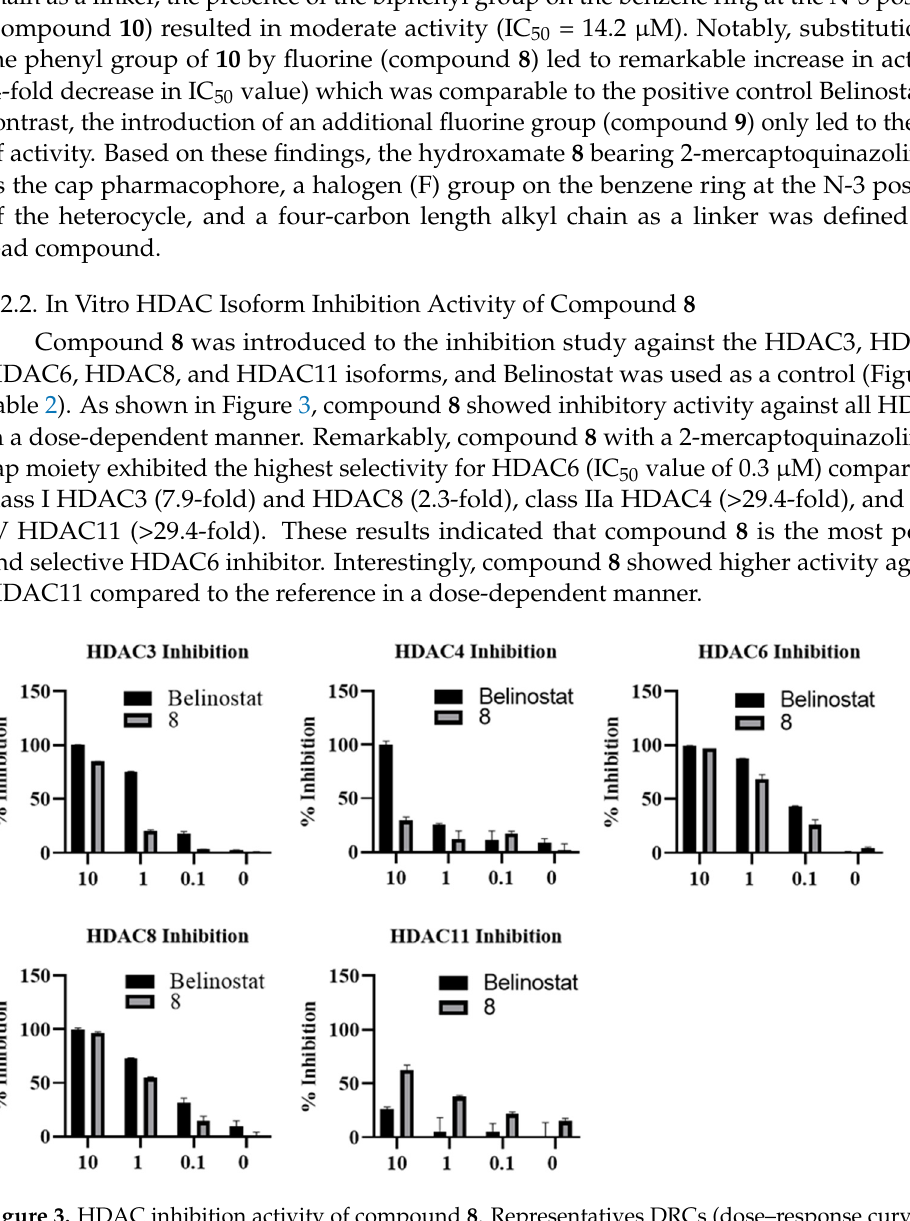
Figure 3. HDAC inhibition activity of compound 8 . Representatives DRCs (dose–response curves) of 8 (closed bars) and reference Belinostat (open bars). Percentage inhibition is shown in each graph. Table 2. HDAC inhibitory activities of compound 8